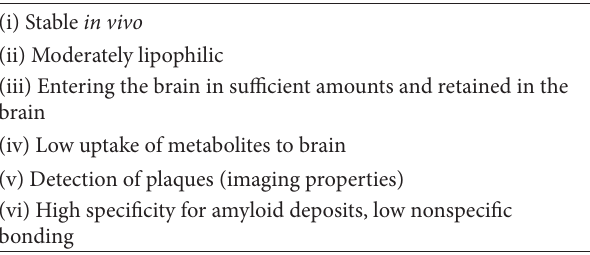
Table 1: Ideal properties for a diagnostic small